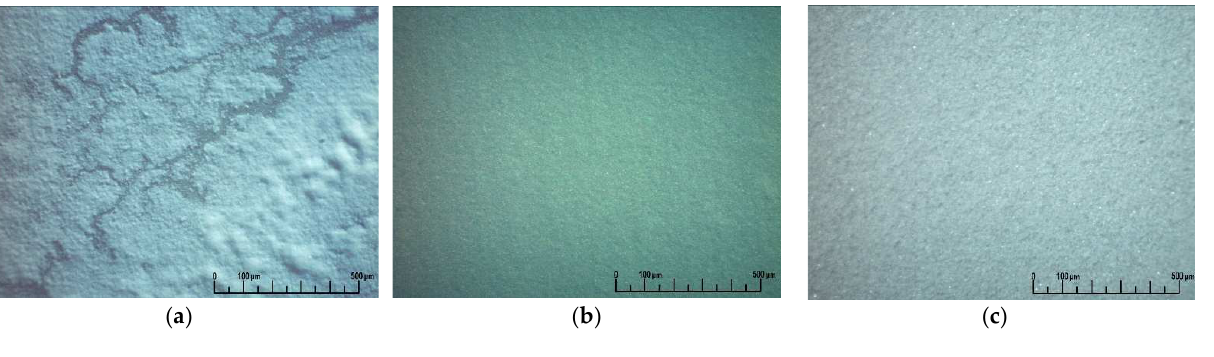
Figure 4. Optical images of the green EPD coatings deposited on the Ni-foil substrate (80 V, 1 min): ( a ) SDC-gn; ( b ) SDC-gn/lec; ( c ) BCS-CuO.